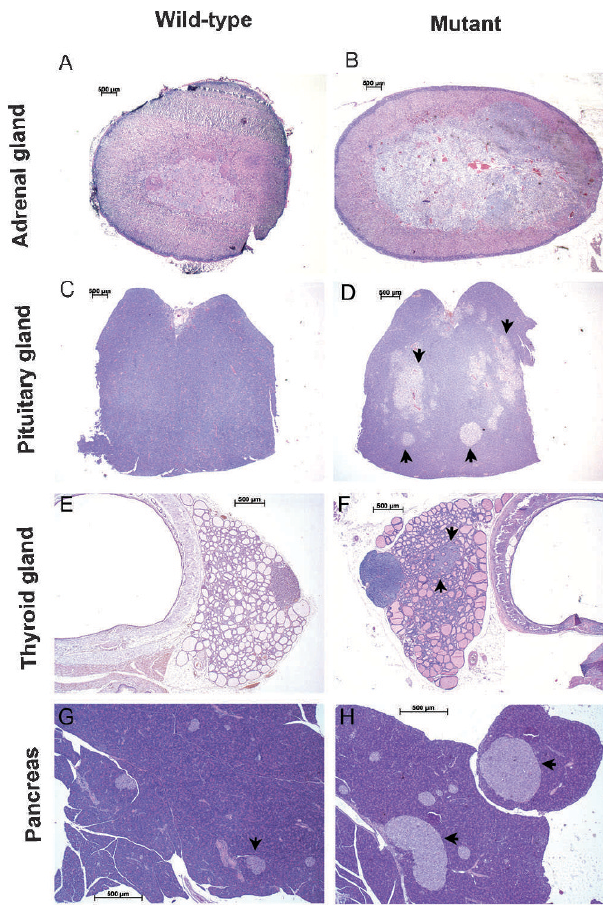
Figure 1 - Histology of rat tissues affected by the MENX syndrome. Adrenal (A, B), pituitary (C, D) and thyroid (E, F) glands, and pancreas (G, H) of wild-type and age-matched MENX-affected (mutant) rats. Multifocal hyperplastic lesions in the anterior pituitary are indicated by arrows (D). A nodule of thyroid C cell hyperplasia is also indicated (F). Pancreatic islet cells are indicated by arrows in panels G and H: as the pictures were taken with the same magnifications the increase in size of the islets in mutant rats can be readily appreciated. Hematoxylin and eosin stain (H&E) original magnification: 20X (A–D); 25X (E, F); 40X (G, H). (Reproduced with permission from: Molatore & Pellegata, 2010 Copyright (cid:2) 2010